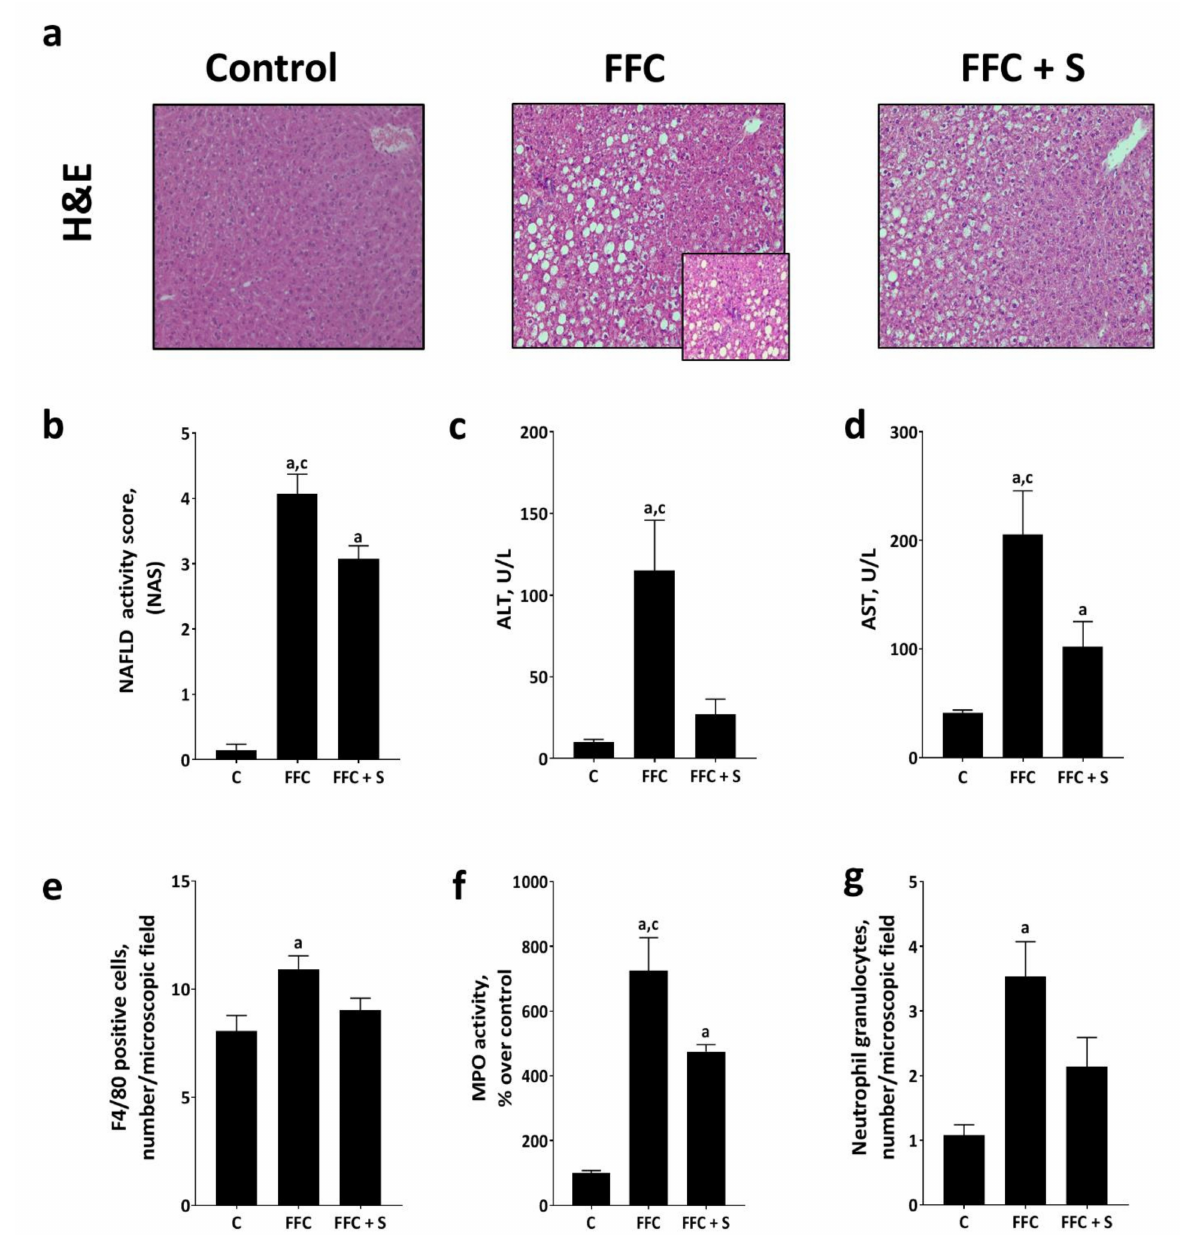
Figure 1. Effect of fortifying the fat-, fructose-, and cholesterol-rich diet with 4E% soybean oil on markers of liver damage in mice. ( a ) Representative pictures (100 × , 400 × ) and ( b ) evaluation of hematoxylin and eosin (H&E) staining using NAFLD activity score (NAS) of liver sections. ( c ) Alanine transaminase (ALT) and ( d ) aspartate transaminase (AST) activity in plasma, ( e ) number of F4/80-positive cells per microscopic field in liver tissue, ( f ) myeloperoxidase (MPO) activity in liver tissue, and ( g ) number of neutrophil granulocytes per microscopic field in liver tissue. Data are presented as means ± SEM, n = 6–8 mice per group with n = 6–8 livers being analyzed per group and measurements. Data of NAS, ALT, AST, MPO, and neutrophil granulocytes were log-transformed before statistical analysis. C-group ALT only n = 4 per group as values were in part below the level of detection. C: control diet; FFC: fat-, fructose-, and cholesterol-rich diet; FFC + S: fat-, fructose-, and cholesterol-rich diet supplemented with soybean oil. a p ≤ 0.05 compared with mice fed the C-diet. c p ≤ 0.05 compared with mice fed the FFC +